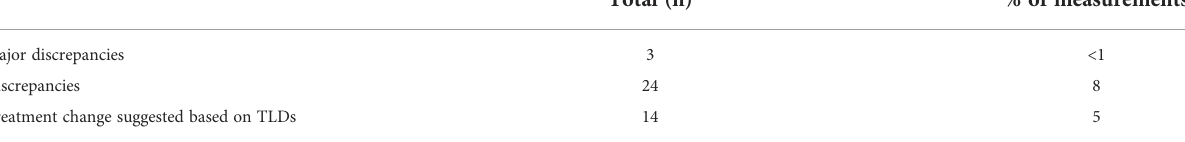
TABLE 1 – Number of TLD measurement cases requiring